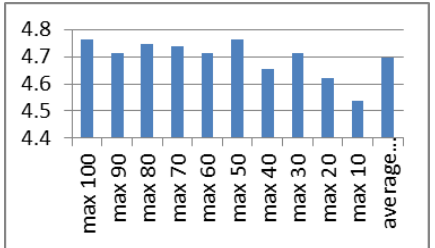
Figure 14. Average odontometric parameters: 100-section series (red), 50-section series (pink)